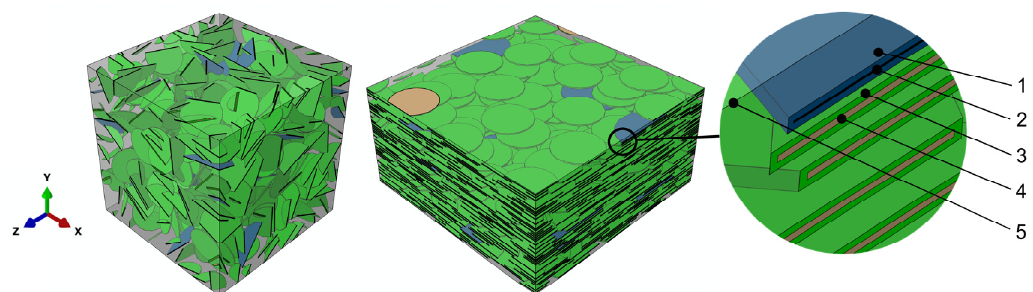
Figure 1. Typical representative volume elements (RVEs) with random placed inclusions ( ρ G = 500, ρ MX = 125, f G = 0.1%, and f MX = 1.6%) and aligned inclusions ( ρ G = 500, ρ MX = 125, f G = 0.1%, and f MX = 6.4%): ( 1 ), graphene/matrix interface; ( 2 ), graphene; ( 3 ), MXene/matrix interface; ( 4 ), MXene; ( 5 ), matrix.